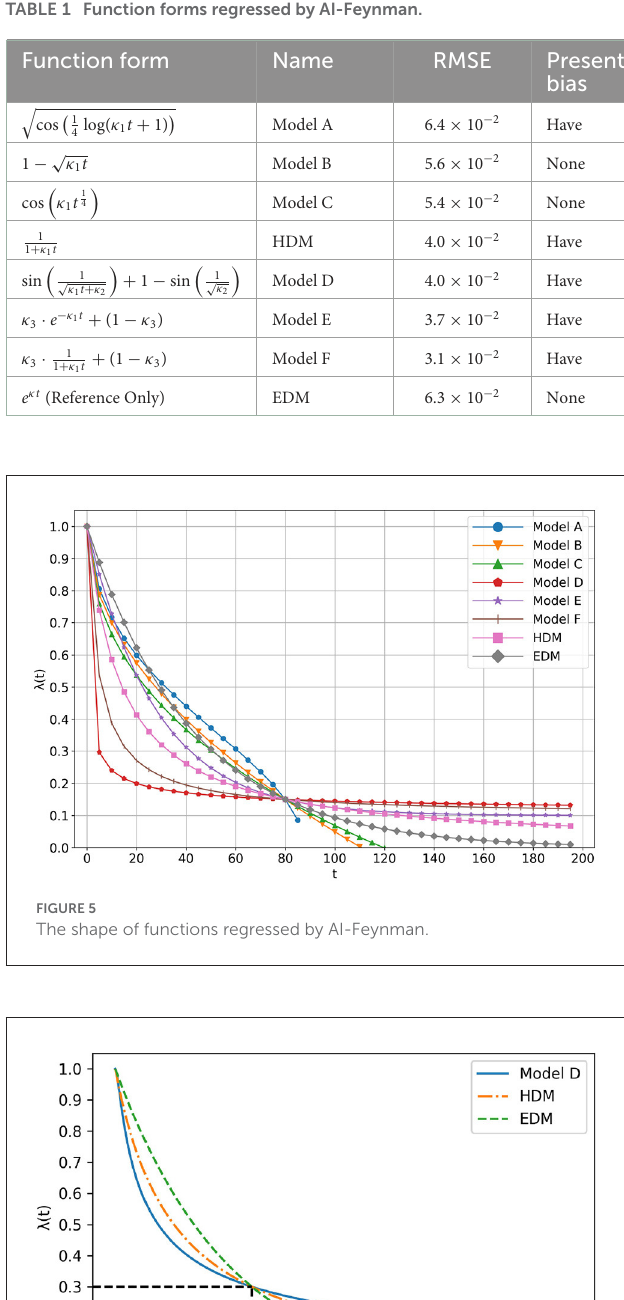
TABLE 1 Function forms regressed by AI-Feynman.